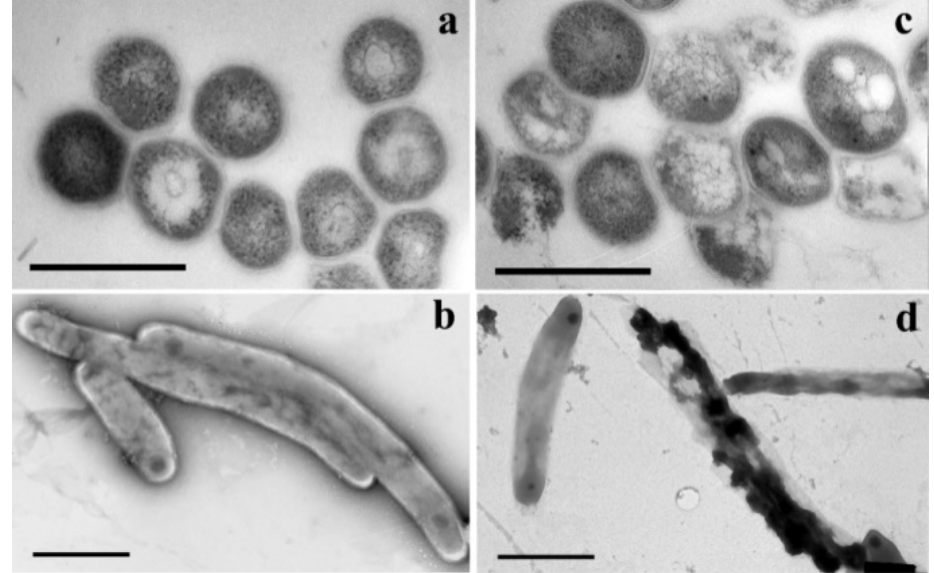
Figure 24. Transmission electron microscopy (TEM) of Mtb H37Rv cells. ( a , b )—intact control cells; ( c , d )—cells cultured in a medium containing the studied nucleoside derivatives; ( a , c )—ultrathin sections; ( b , d )—cells adsorbed on supporting film and stained with uranyl acetate. Scale ( a , c )—0,5 µm; ( b , d )—1 µm.